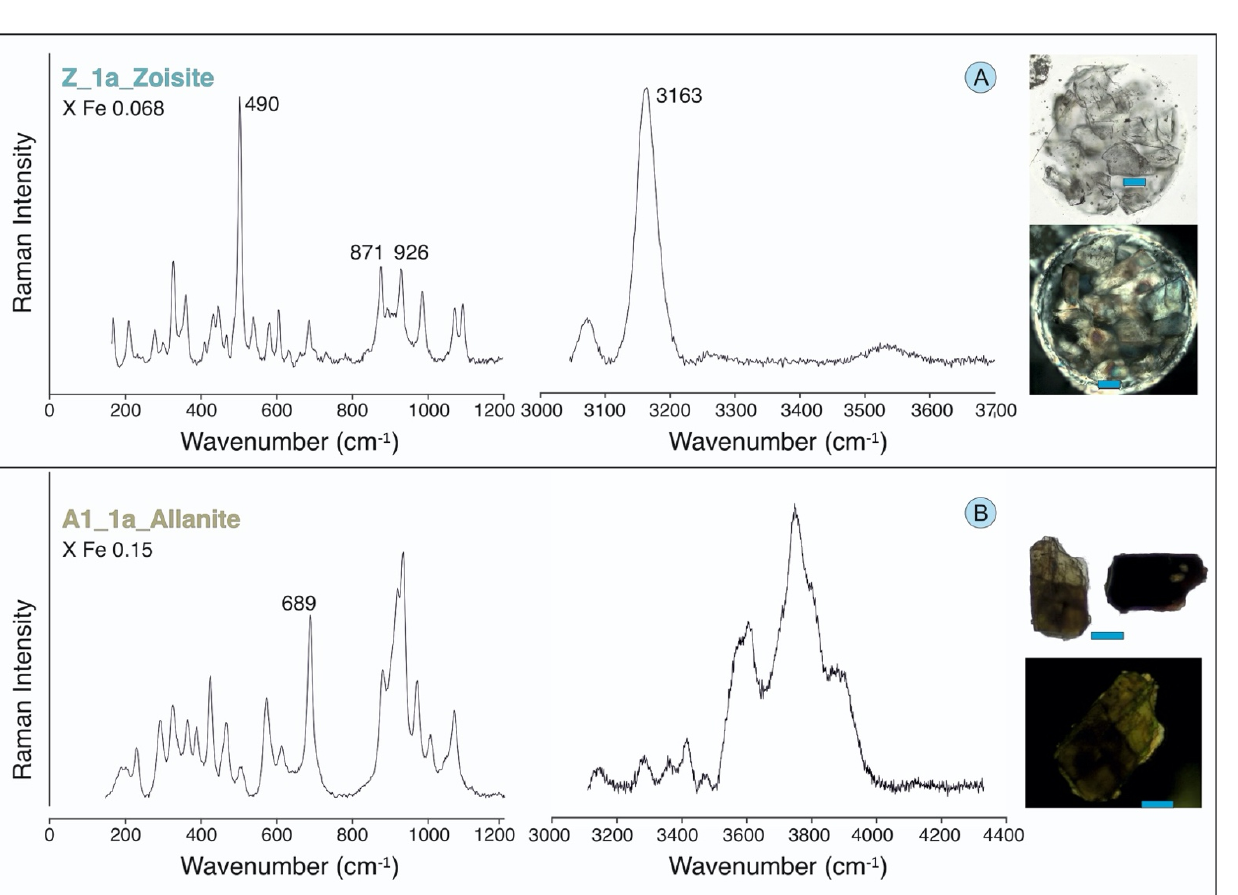
Figure 4. Characterization of zoisite and allanite standards Z ( A ) and A1 ( B ). Zoisite, identified by major Raman peaks at 490 cm − 1 and − 3150 cm − 1 , is colorless, with anomalous interference colors. Allanite, identified by a sharp peak at 689 cm − 1 and several wide peaks in the high-frequency region, has strong pleochroism and second-order interference colors. Blue bar for scale = 100 µm.